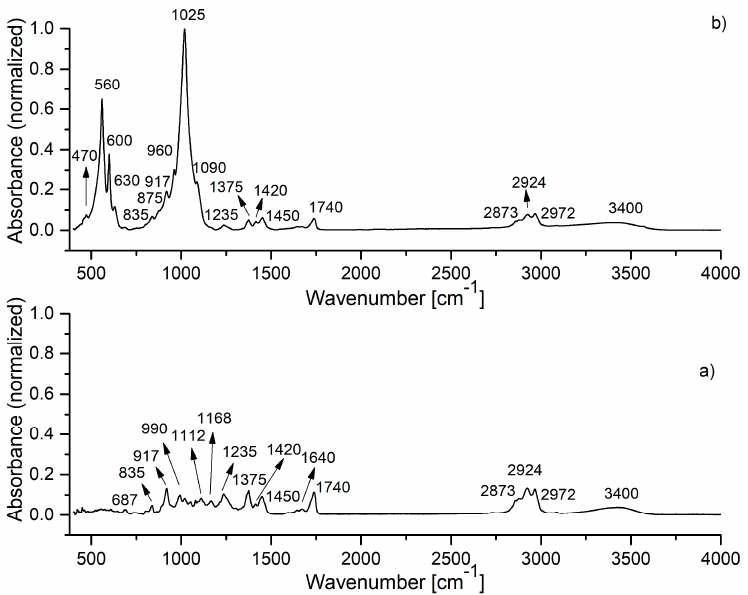
Figure 4. FTIR spectrum of: ( a ) lavender EO; ( b ) HAp-L sample.